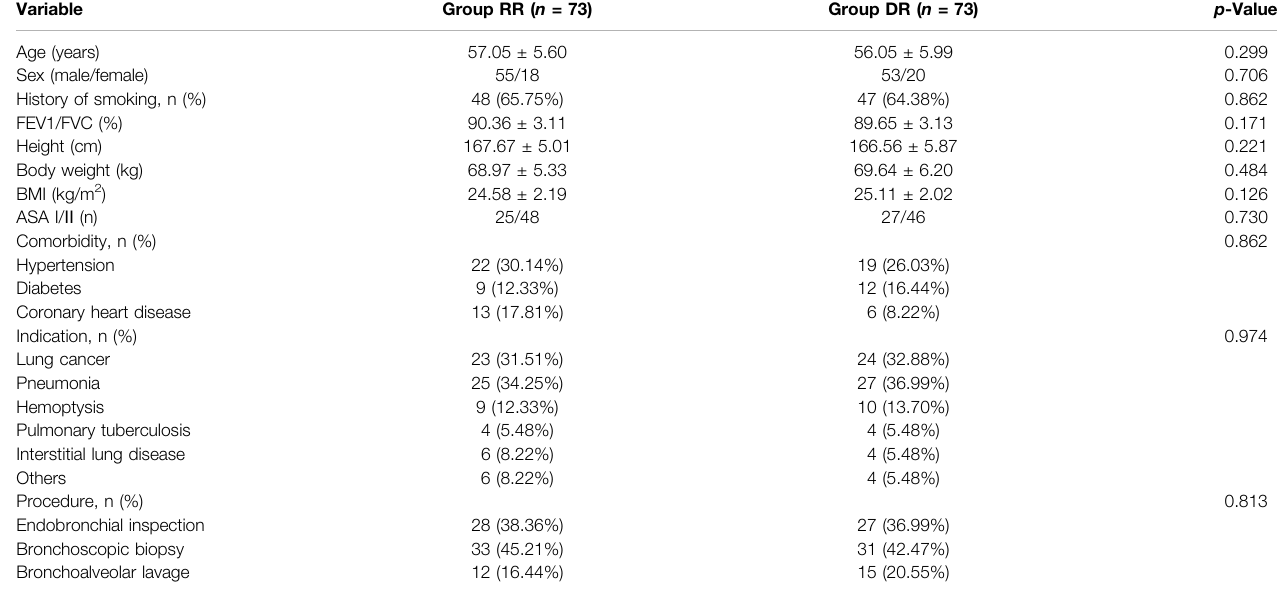
TABLE 1 | Demographic characteristics and perioperative data. Variable